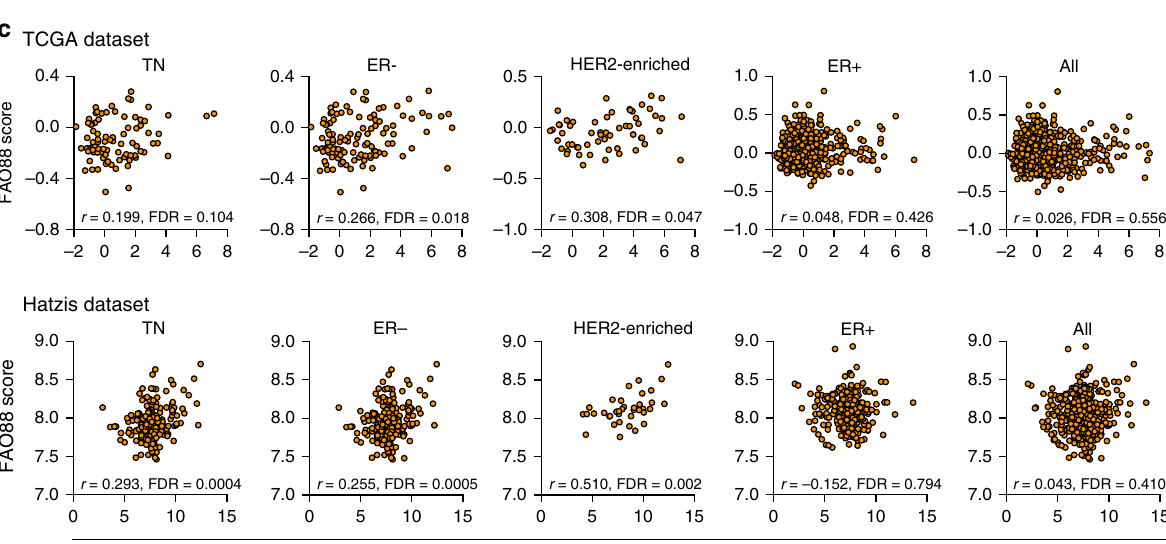
Fig. 4 Fatty acid oxidation in AKR1B10 High cells and breast tumours. a Dependency of cells on glutamine (left panel) and fatty acid (right panel) oxidation monitored using the Mito Fuel Flex test (see Methods). HCC1395 and MDA-MB-231, n = 8 ± SD; MDA-MB-453, n = 3 – 4 ± SD. b Change in OCR ( Δ OCR) following palmitate-BSA addition calculated as (OCR at the time of palmitate-BSA injection — fi nal basal OCR). n = 3 ± SD. c , Pearson correlation of AKR1B10 expression and FAO88 score in triple negative (TN), ER − , HER2-enriched, ER + and all breast cancers in the TCGA and Hatzis et al. 24 datasets. To determine false discovery rates (FDR), the Pearson correlation P values were adjusted using the Benjamini-Hochberg method for multiple comparisons in each independent breast cancer clinical cohort. ns, not signi fi cant; * P < 0.05; ** P < 0.01; *** P < 0.001, unpaired t -test ( a , b